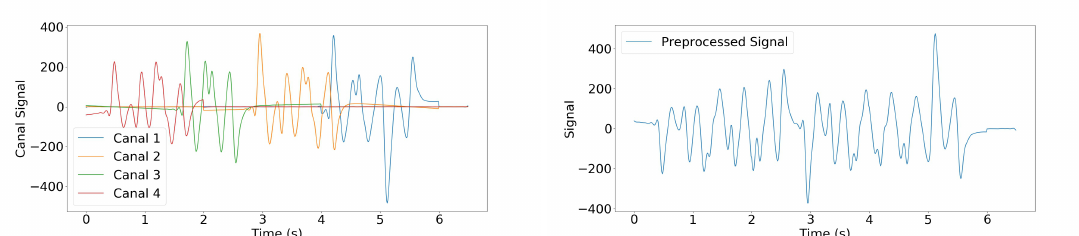
Figure 3. Example of raw ( left ) and preprocessed ( right ) signals resulting from medical staff walking on the sensor. In this case, no channel was set to zero during Step